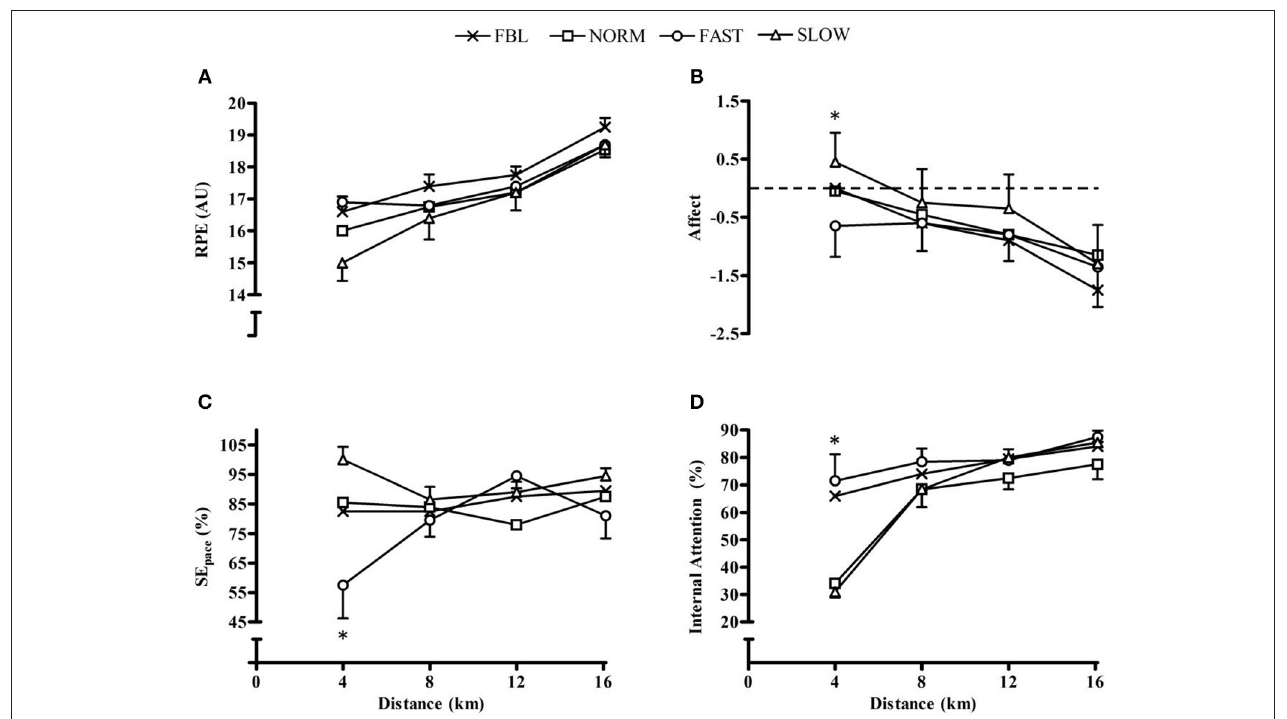
FIGURE 2 | Whole-trial mean and SEM psychological responses for each condition across distance quartiles, illustrating significant interaction effects. (A) RPE; (B) Affect, *denotes significantly lower affect in SLOW than both FBL and FAST ( p ≤ 0.002); (C) SE pace , *denotes significantly lower SE pace during FAST than all other conditions ( p ≤ 0.001); and (D) Attentional focus, *denotes significantly higher internal attention during FBL than NORM ( p =